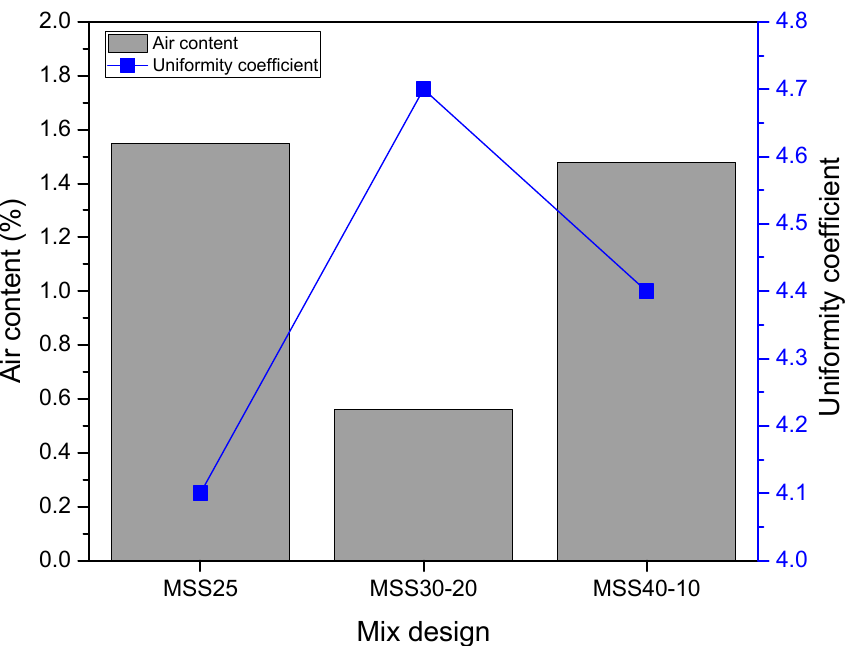
Figure 4. Air content of fresh